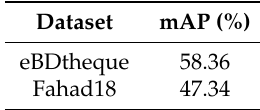
Table 7. The model trained on the DCM772 dataset generalizes well on other datasets such as Fahad18 or eBDtheque.